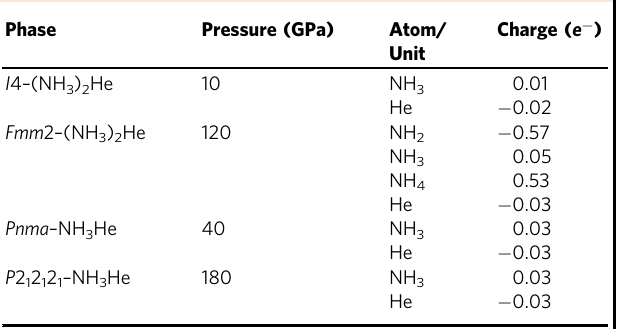
Bader charges of the I 4 phase of (NH 3 ) 2 He at 10GPa, the Fmm2 phase of (NH 3 ) 2 He at 120GPa, the Pnma phase of NH 3 He at 40GPa, and the P 2 1 2 1 2 1 phase of NH 3 He at 180GPa. A negative (positive) sign indicates an electron gain (loss) for the particular atom or